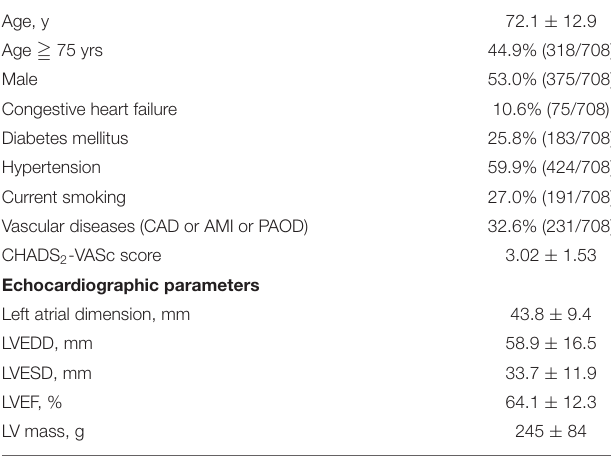
TABLE 1 | Baseline characteristics of the patients at enrollment ( n = 708).